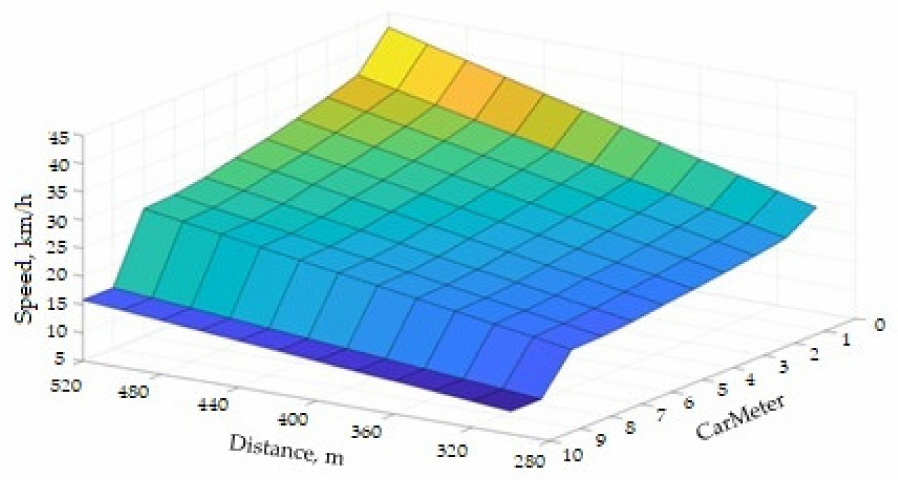
Figure 5. Calculated driving speed. Table 2. Vehicle speed